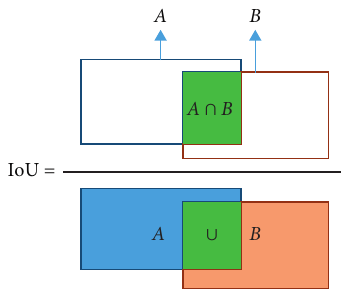
Figure 2: Schematic illustration of